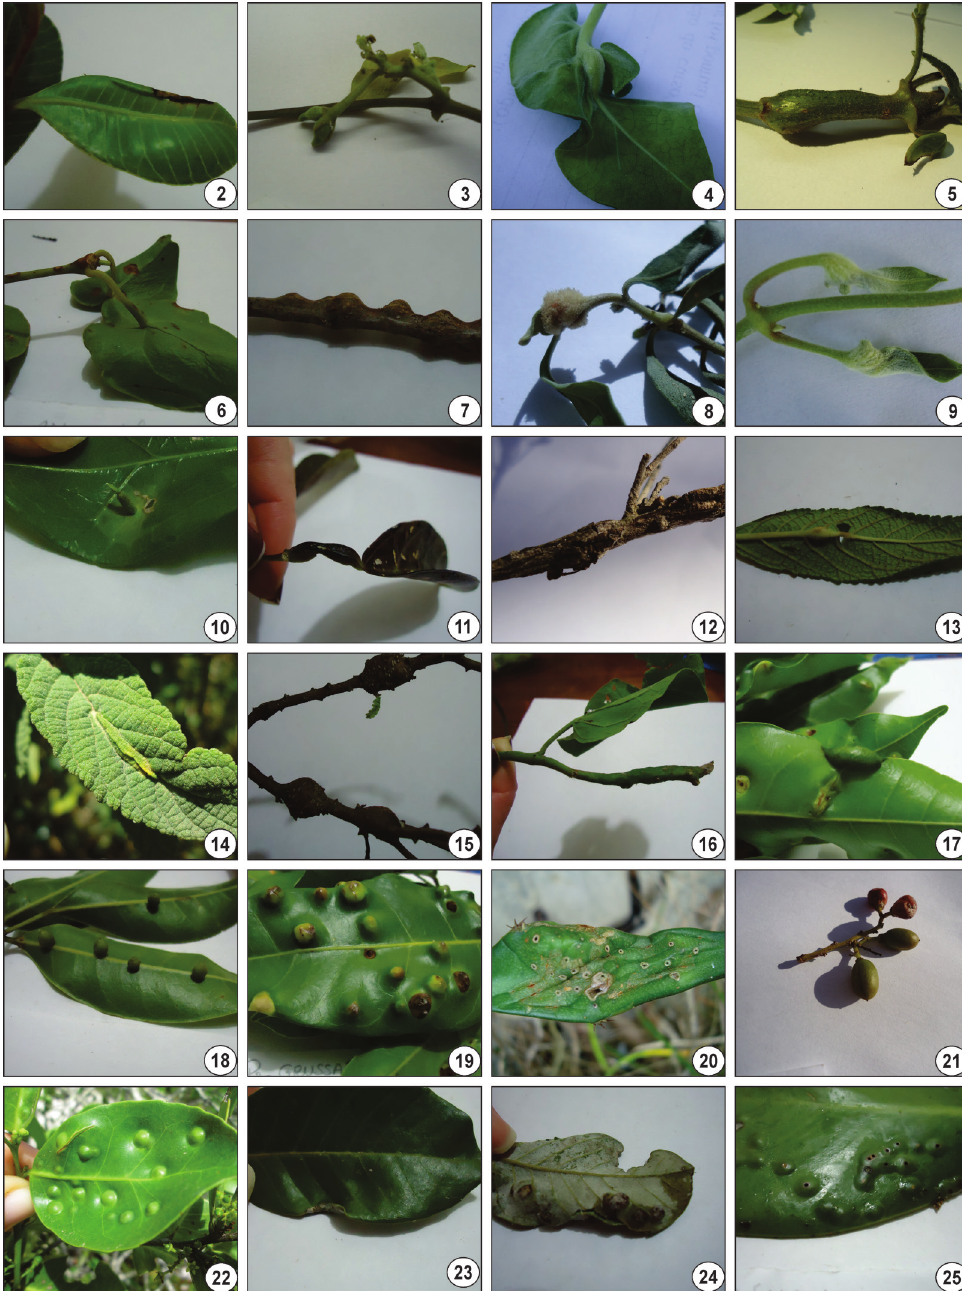
Figures 2-25 - Galling insects from Parque Estadual da Costa do Sol and RPPN Fazenda Caruara (RJ, Brazil). 2, Lithraea brasiliensis , marginal roll. 3-4, 3, Oxypetalum banksii , globoid bud gall, 4, fusiform leaf vein. 5, Eupatorium punctulatum , fusiform stem gall. 6, Mikania hoehnei , stem fusiform gall. 7-8, Vernonia rufogrisea , 7, stem gall, 8, petiole gall. 9, Asteraceae sp., globoid leaf gall. 10-11, Fridericia conjugata , 10, conical leaf gall, 11, fusiform gall. 12, Euploca polyphylla , stem gall. 13-15, Varronia curassavica , 13, leaf vein gall, 14, lenticular leaf vein gall, 15, stem gall. 16, Tournefortia villosa , stem gall. 17-19, Protium heptaphyllum , 17, marginal roll, 18, globoid leaf gall, 19, lenticular gall. 20, Hylocereus setaceus , stem gall. 21-22, Maytenus obtusifolia , 21, fruit gall, 22, lenticular leaf gall. 23-24, Couepia ovalifolia , 23, marginal roll, 24, globoid leaf gall. 25, Clusia fluminensis , lenticular leaf